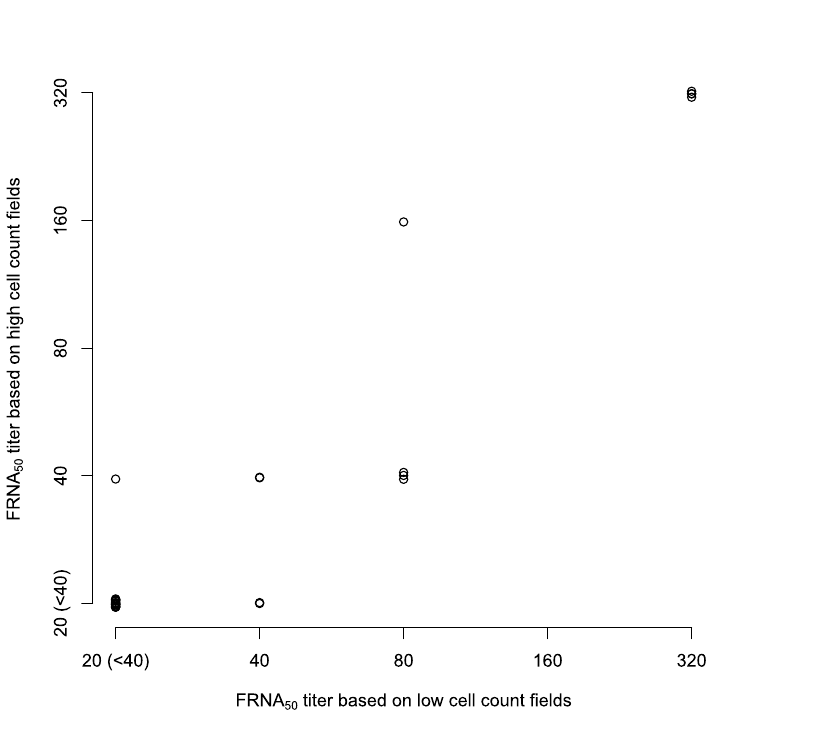
Fig 3. FRNA 50 titer estimate in fields with varying cell count. Comparison of FRNA 50 titer estimates calculated using low cell count and high cell count fields. For each plate and column replicate, the field corresponding to either the minimum or maximum total cell count was used to estimate functional